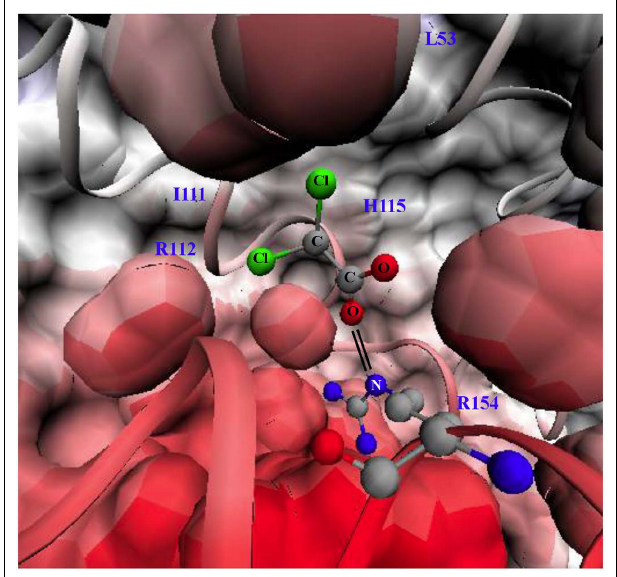
FIGURE 1 | Structure of pyruvate dehdyrogenase kinase 2 (PDK2) bound with dichloroacetate (DCA). Surface and ribbon representation of PDK2 with DCA bound is shown.The carboxylate group of DCA forms a salt bridge (double black line) with arginine 154 of PDK2.The structures were generated using visual molecular dynamics (VMD) version 1.8.6 with the coordinates acquired from Protein Data Bank (PDB#2BU8; Knoechel etal., 2006). L53 (leucine 53), I111 (lsoleucine 111), H115 (histidine 115), R112 (arginine 112), R154 (arginine 154). Black lines indicate salt bride between R154 and